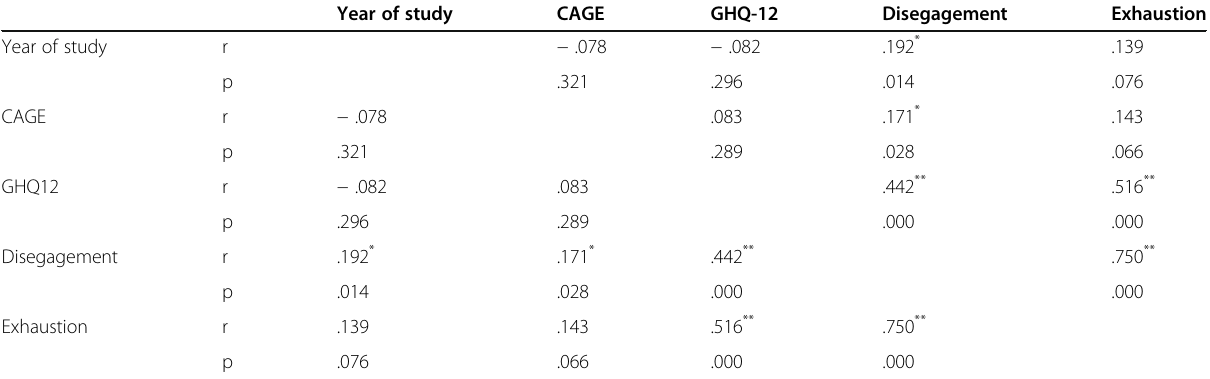
Table 2 Correlations between the studied values